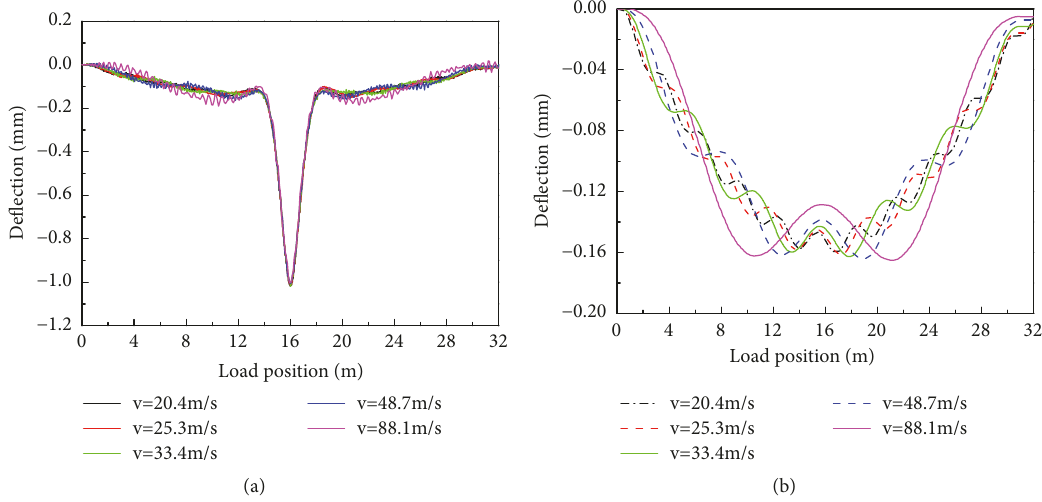
Figure 11: Mid-span deflection time-history for the double simply supported rail-bridge system under cancellation condition: (a) first beam; (b) second